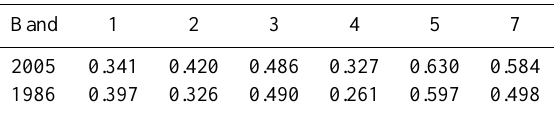
Table 2. C-correction coefficients derived for the non-Lambertian corrected